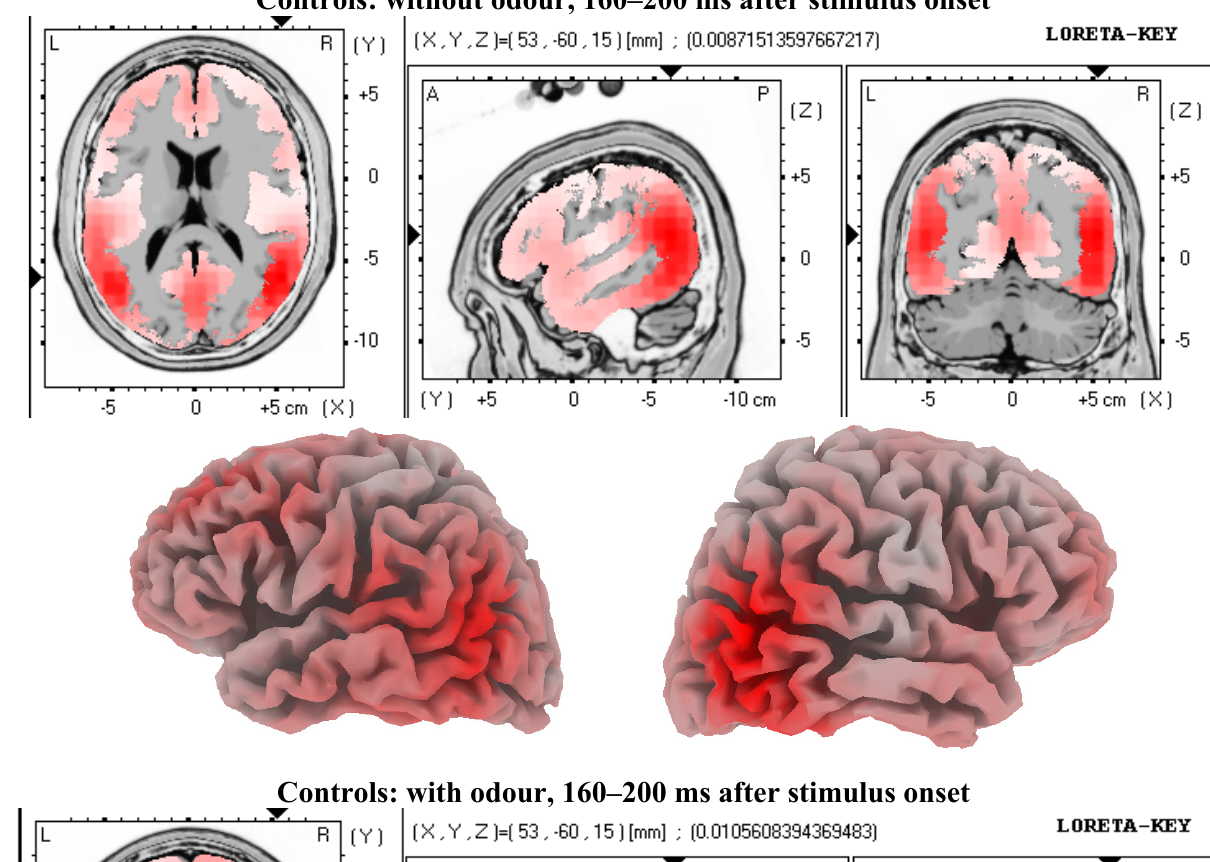
Figure 3. LORETA solutions for the early odour-related effect in controls. Maximum brain activity difference between odour versus no-odour can be seen at the left fronto-temporal area. Controls: without odour, 160–200 ms after stimulus onset